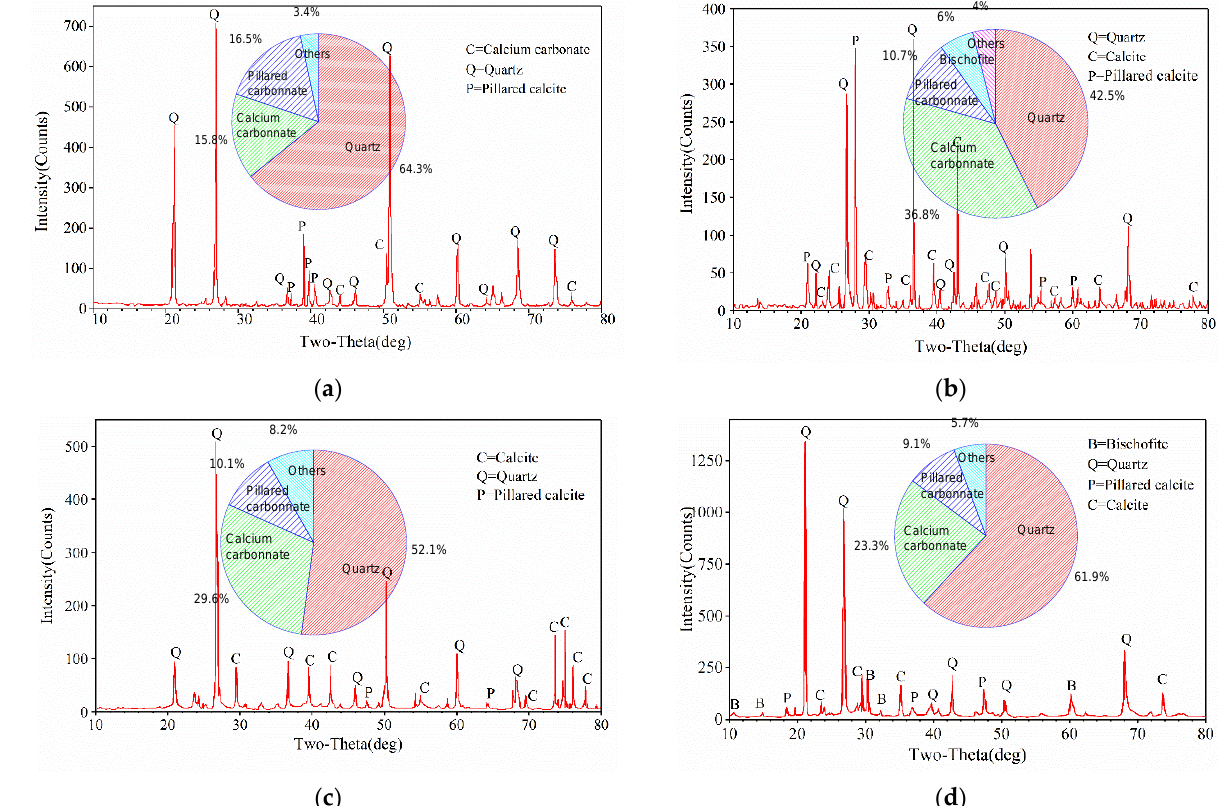
Figure 12. X-ray diffraction test results. ( a ) 0.5 mol/L. ( b ) 1.0 mol/L. ( c ) 1.5 mol/L. ( d ) 2.0 mol/L.